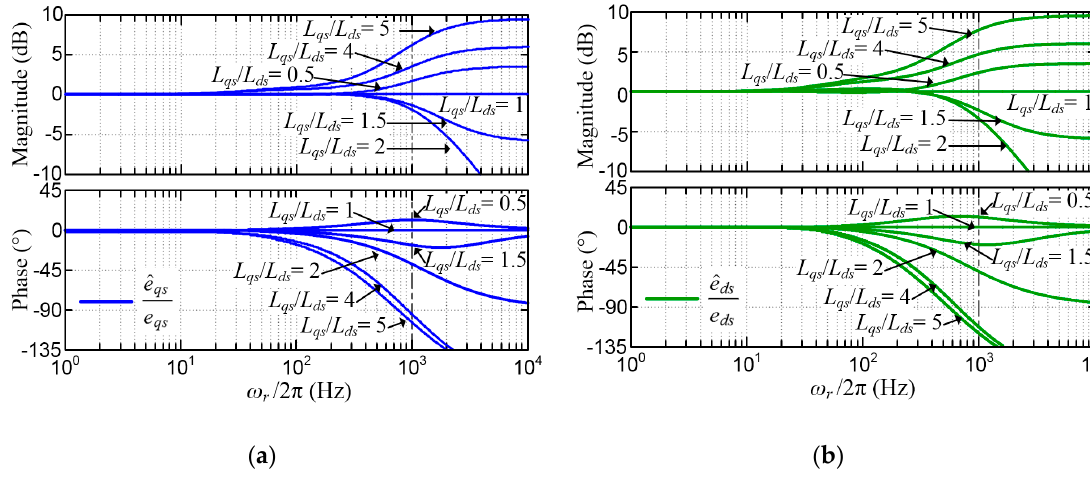
Figure 7. Frequency response of ( a ) ˆ e qs / e qs ; ( b ) ˆ e ds / e ds .